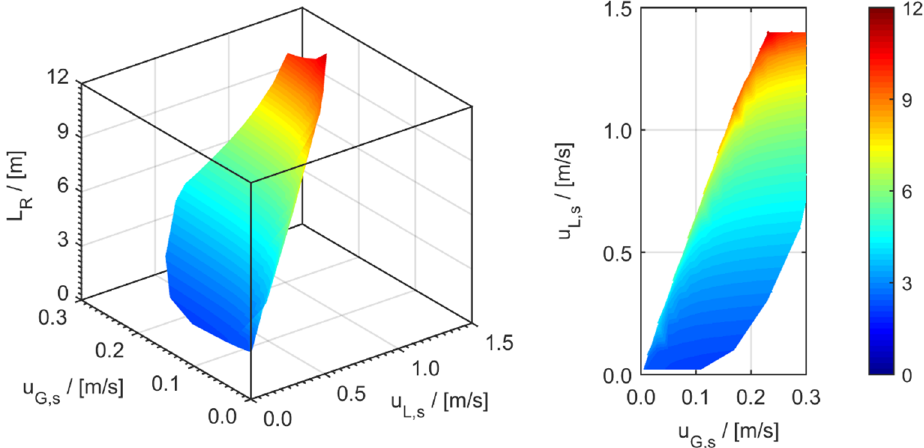
Figure 11. Required reactor length of particle-packed minichannel reactors operating at different gas and liquid superficial velocities.